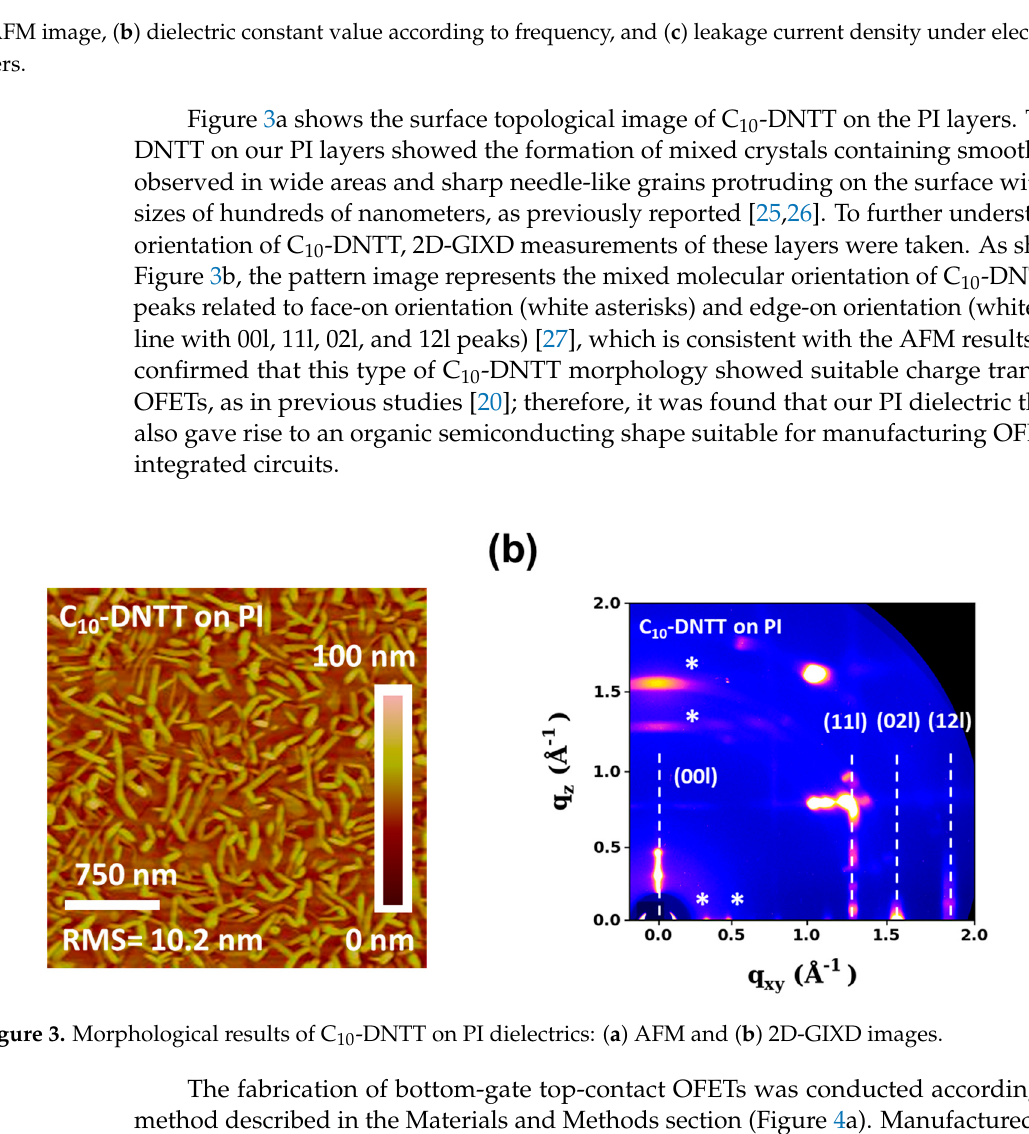
Figure 4. ( a ) Schematic illustration of OFET device and electrical properties: ( b ) transfer, ( c ) output, and ( d ) transfer curve with bias stress test.